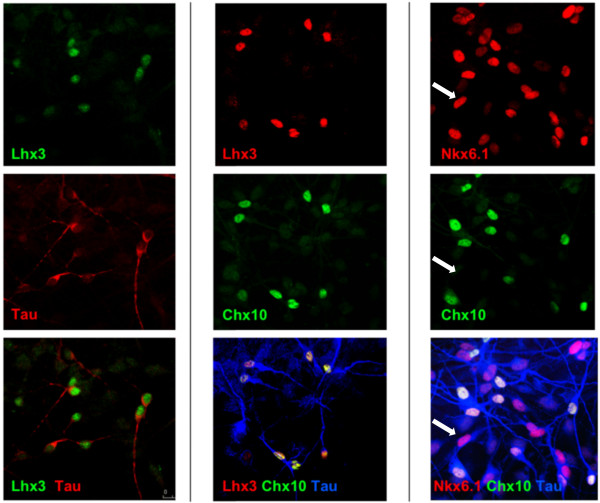
Characterization of SPC-01 differentiation. Differentiation of SPC-01 by removal of growth factors and 4-OHT for 7 days gives rise to tau+ neurons (left panel). Consistent with the homeodomain transcription-factor profile observed in the undifferentiated cells, a subset of these tau+ neurons coexpress LHX3 and CHX10, indicative of V2a interneurons (middle panel). However, a subpopulation of NKX6.1+/CHX10- neurons can also be observed (right panel, white arrows).